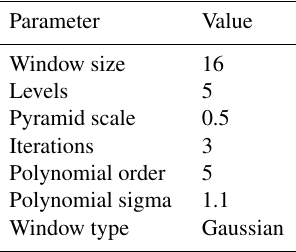
Table 2. The values of parameters used in the Farnebäck algorithm for detection of optical flow vectors in this